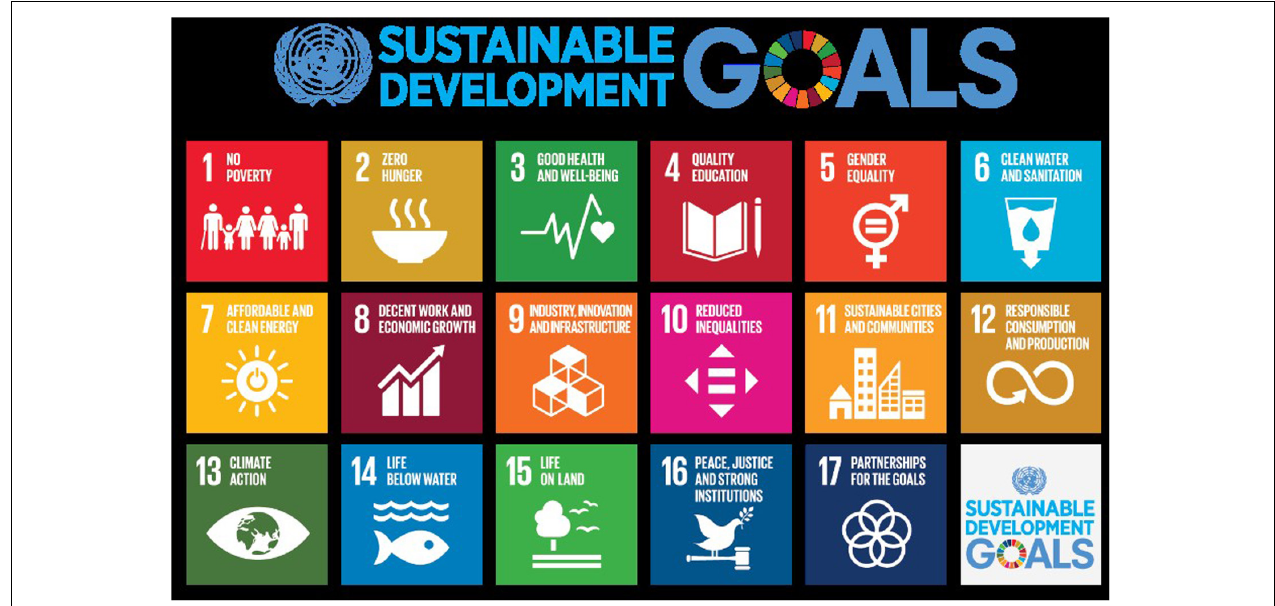
FIGURE 1 | Sustainable development goals, SDGs (United Nations, 2015).